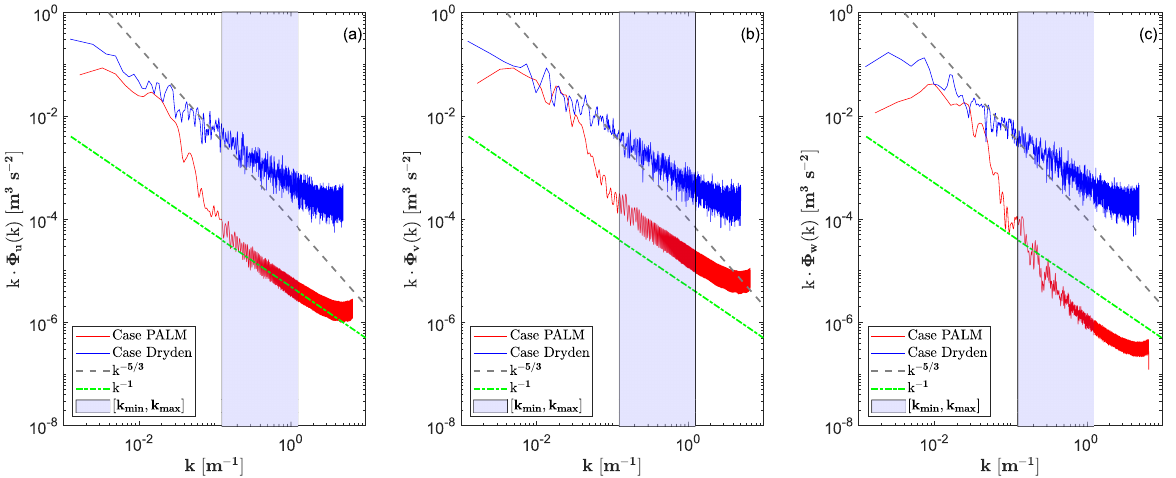
Figure 16. Spectra of wind velocity component ( a ) u , ( b ) v and ( c ) w , derived from flight simulation output data of scenario Piz Corvatsch at an average altitude of 7500 ft (2280 m). The grey dashed line represents the reference − 3/5-slope according to Kolmogorov’s law [71]. The − 2-slope is plotted in green. The box in light blue shading indicates the time frame of interest for the flight simulation experiment, which is determined by the lower limit wave number k min of 2 π /50 m − 1 and the high limit wave number k max of 2 π /5 m − 1